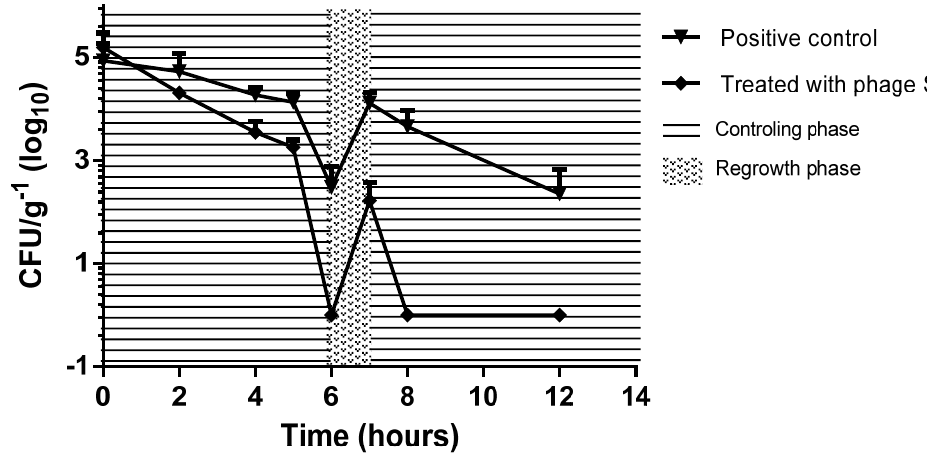
Figure 3. S. e. Enteritidis colonies counting after phage SM1 application on poultry litter. The three-phase behavior of the bacterial count after a single phage use shows the S. e. Enteritidis regrowth potential.